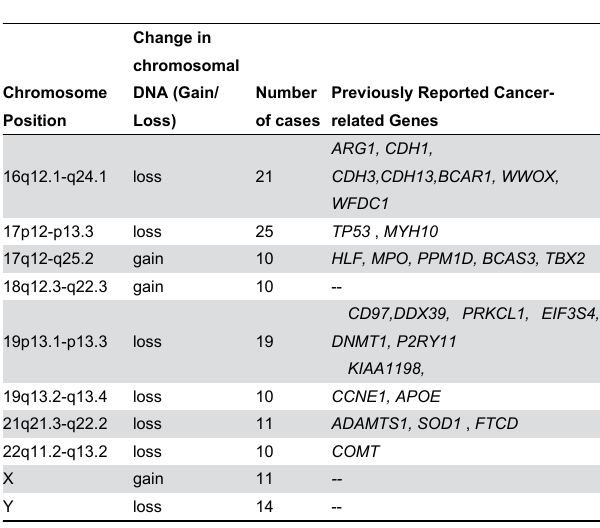
Table 1. Recurrently altered regions (RARs) arranged by